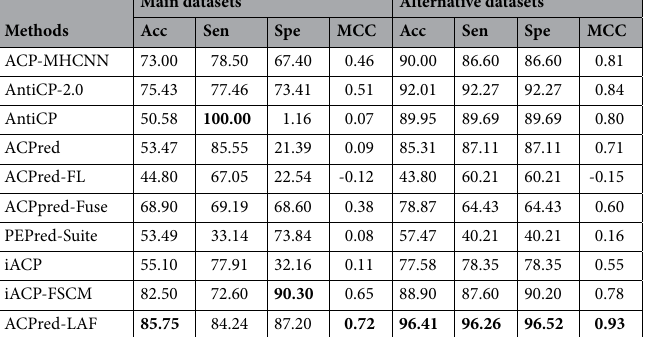
Table 12. Comparing the results achieved for ACP-MHCNN to the state-of-the-art anticancer peptide predictors on the main and alternative datasets used in 16,17,60 . Bold items indicate the best values found by the